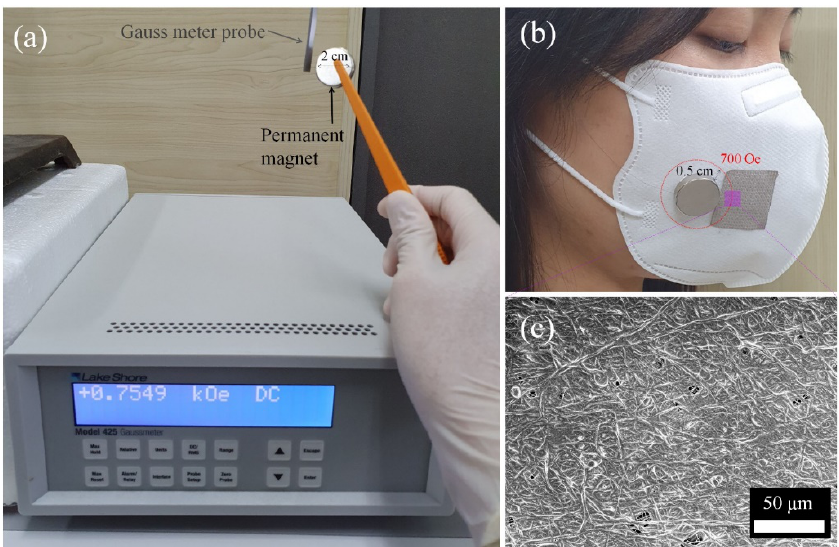
Figure 10. ( a ) Magnetic field measurement for a permanent magnet, ( b ) prototype mask using ME membrane filters, and ( c ) SEM images of ME membranes after PM filtration.